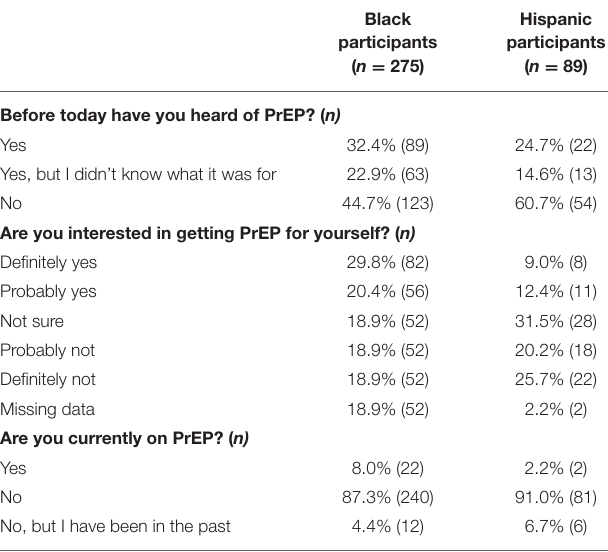
TABLE 5 | Options for asking about PrEP more comfortable for the patient (select